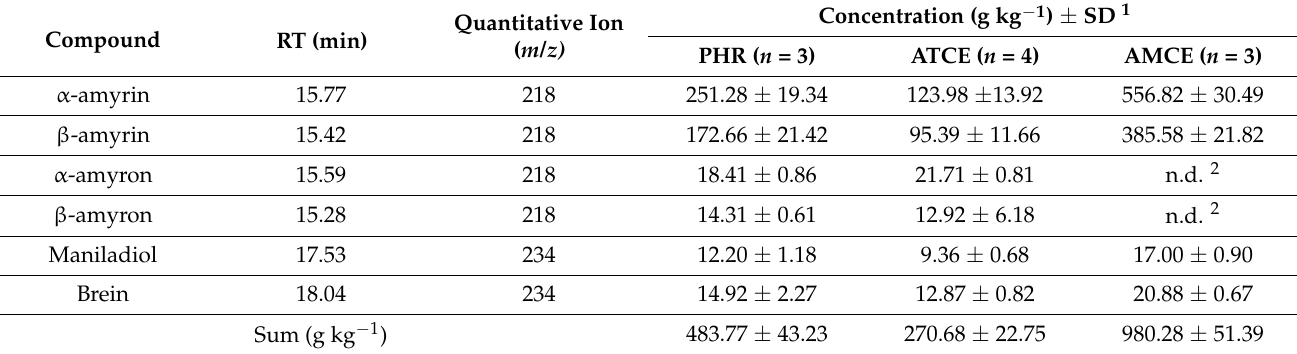
Table 3. Quantitation of identified neutral triterpenes in the